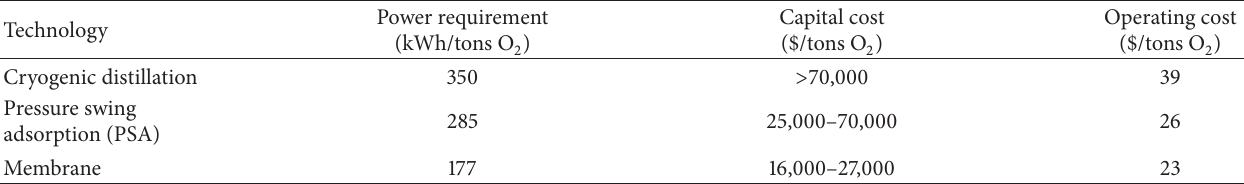
Table 9: Economical study for the production of 20 tons of enriched oxygen (35mol%) with different technologies